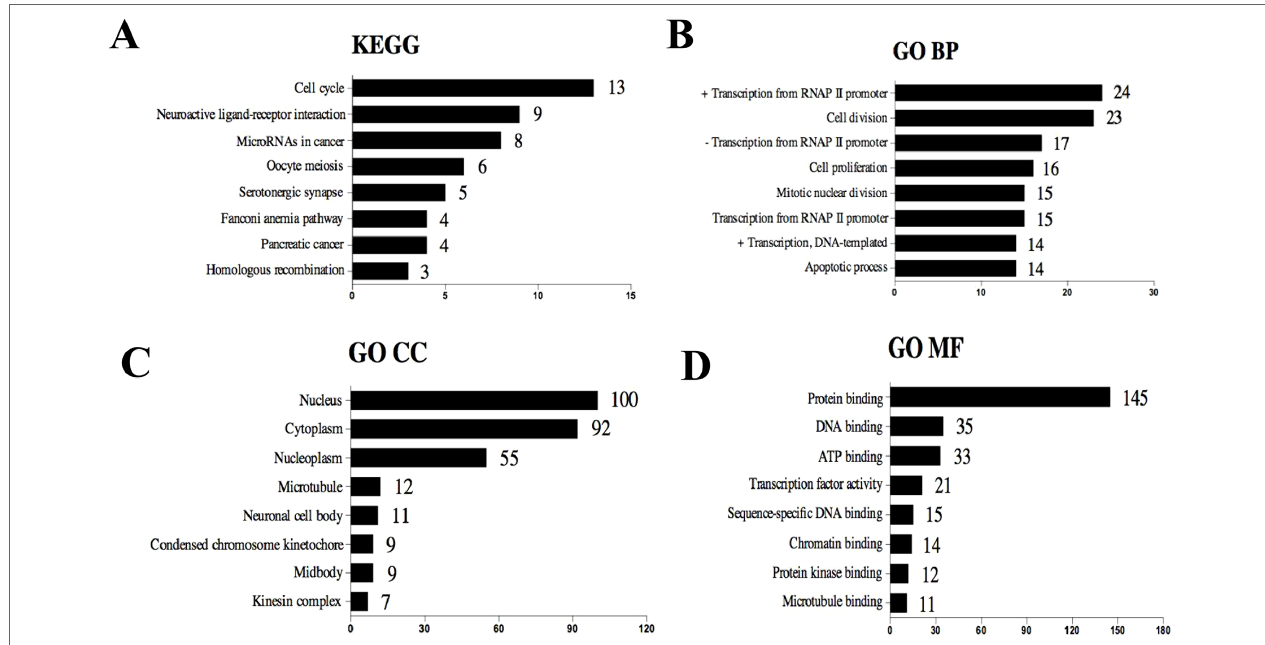
FIGURE 3 | Top eight (sorted by count) KEGG pathways and GO terms identified among DEGs associated with survival using DAVID. (A) KEGG pathways. (B) GO term of Biological Process. (C) GO term of Cellular Component. (D) GO term of Molecular Function. “+” represents positive regulation, and “−” represents negative